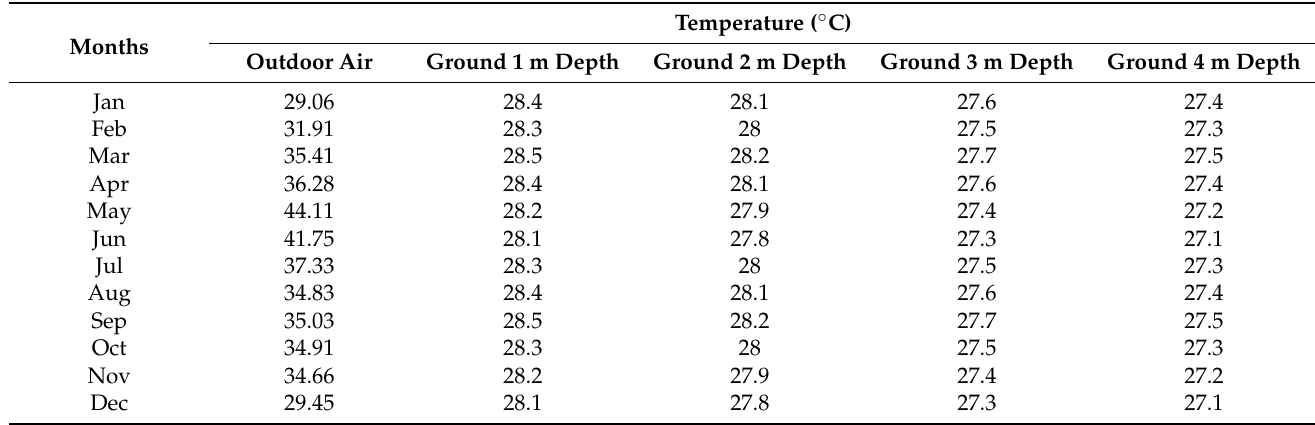
Table 5. Average monthly outdoor air temperatures and simulated ground temperatures at 1, 2, 3, and 4 m